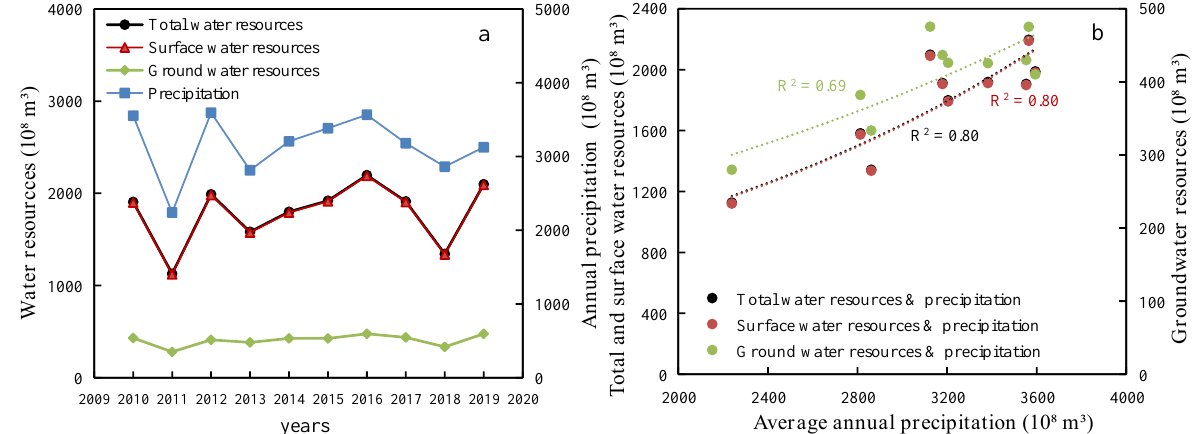
Figure 9. Temporal dynamics of water resources and precipitation from 2010 to 2019 ( a ) and the relationship between average annual precipitation (in units of 10 8 m 3 /year converted from mm/year from multiple areas of Hunan Province), and annual total water resources (in black), surface water resources (in red), and groundwater resources (in green) ( b ).